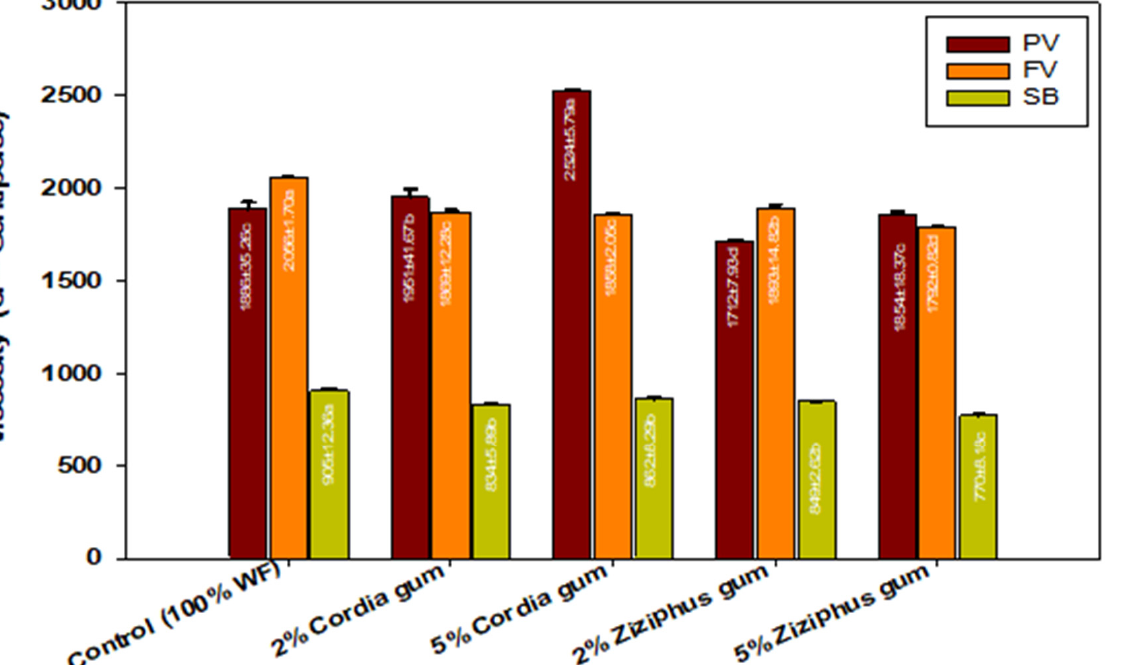
Figure 2. Textural properties of wheat flour dough mixed with Cordia and Ziziphus gum blends . Values followed by different letters in same color bars are significantly different at p ˂ 0.05 .